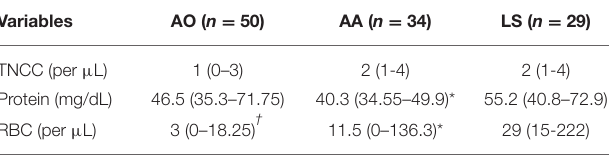
TABLE 1 | Comparison of fluid analysis parameters across all samples.